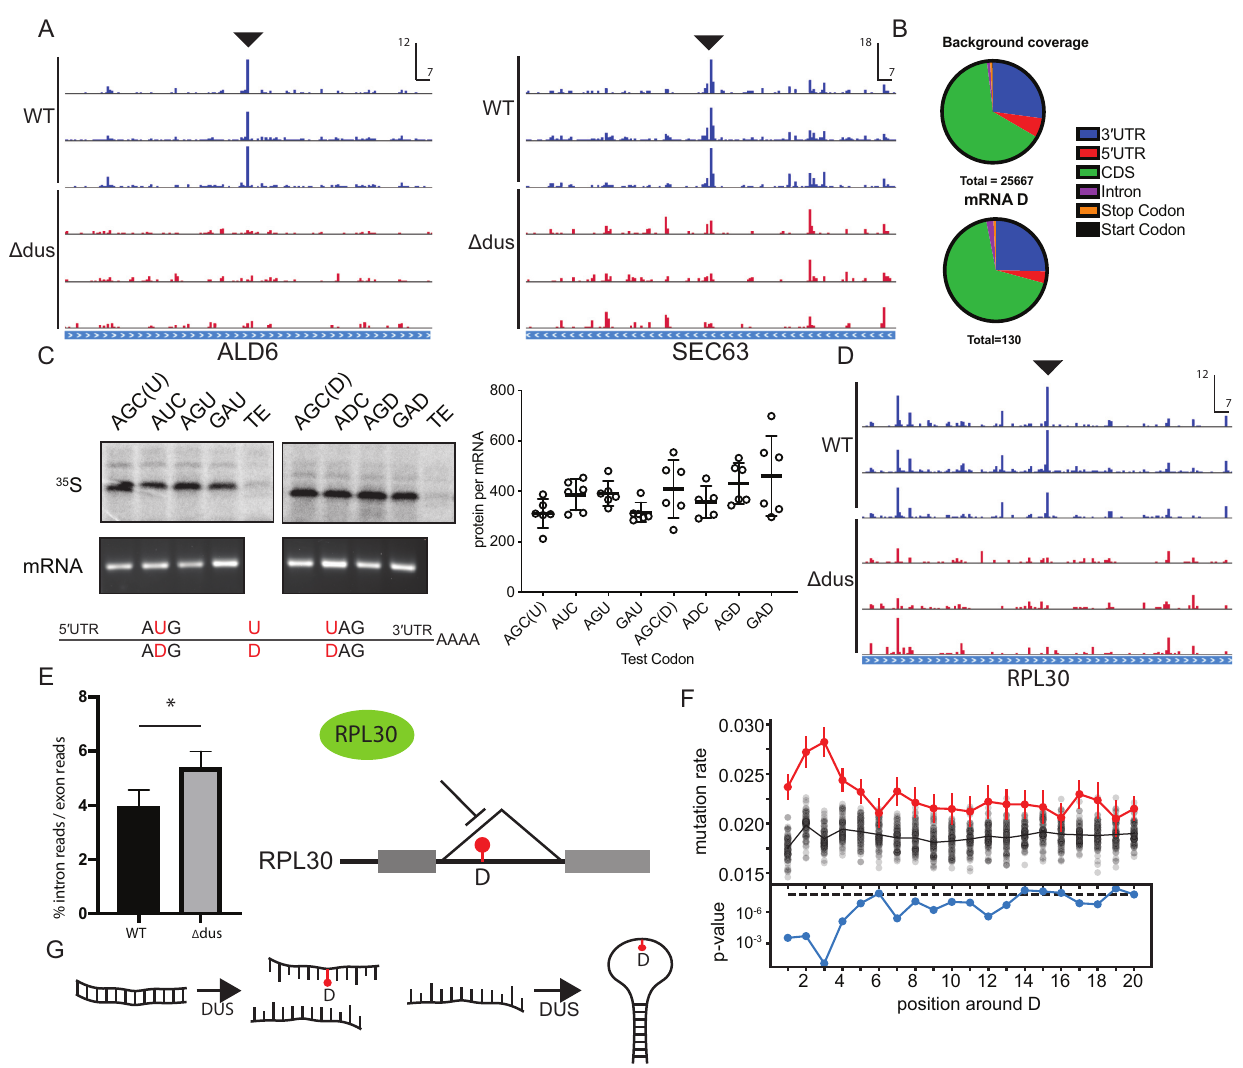
Fig 3. D-seq identifies dihydrouridine sites in mRNAs. (A) Plots of cDNA end positions in ALD6 and SEC63 mRNAs. D peaks are highlighted. Scale in RPM and bp. (B) Distribution of D sites among mRNA features, and background distribution of features for all sites interrogated for D. (C) SDS-PAGE gels showing Top7 protein produced from U and D containing mRNAs with 4 different test codons. Denaturing glyoxal agarose gel showing mRNA integrity. All 4 test constructs showed no significant difference in protein produced per mRNA +/- D. Schematic of U/D mRNAs with U/D positions highlighted in red. (D) Plots of cDNA end positions for intronic D in RPL30 mRNA. D peak is highlighted. Scale in RPM and bp. (E) DUS KO strain has increased ratio of RPL30 intron mapping reads to exon mapping reads ( p < 0.05, Student’s t test). Model of regulation of RPL30 pre-mRNA splicing by RPL30 protein. (F) mRNA sequences flanking Ds have higher DMS reactivity indicating greater flexibility. Plot of median DMS-induced mutation rate in 25 nt window flanking D site. Red trace is median DMS reactivity surrounding D positions. Black dots are median DMS reactivity for randomly selected set of background positions. Blue is p -value for difference in DMS reactivity for sequences flanking D or background sites. (G) D has multiple impacts on RNA structure. D both promotes loop formation and antagonizes duplex formation. The data underlying this figure can be found in S3 Table. D-seq, dihydrouridine sequencing; DMS, dimethyl sulfate; DUS, dihydrouridine